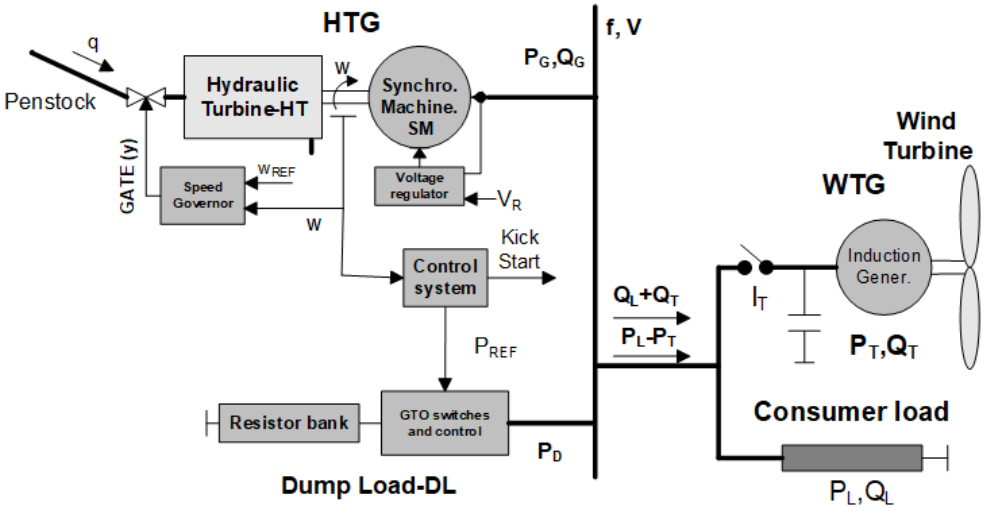
Figure 1. Wind-hydro power system